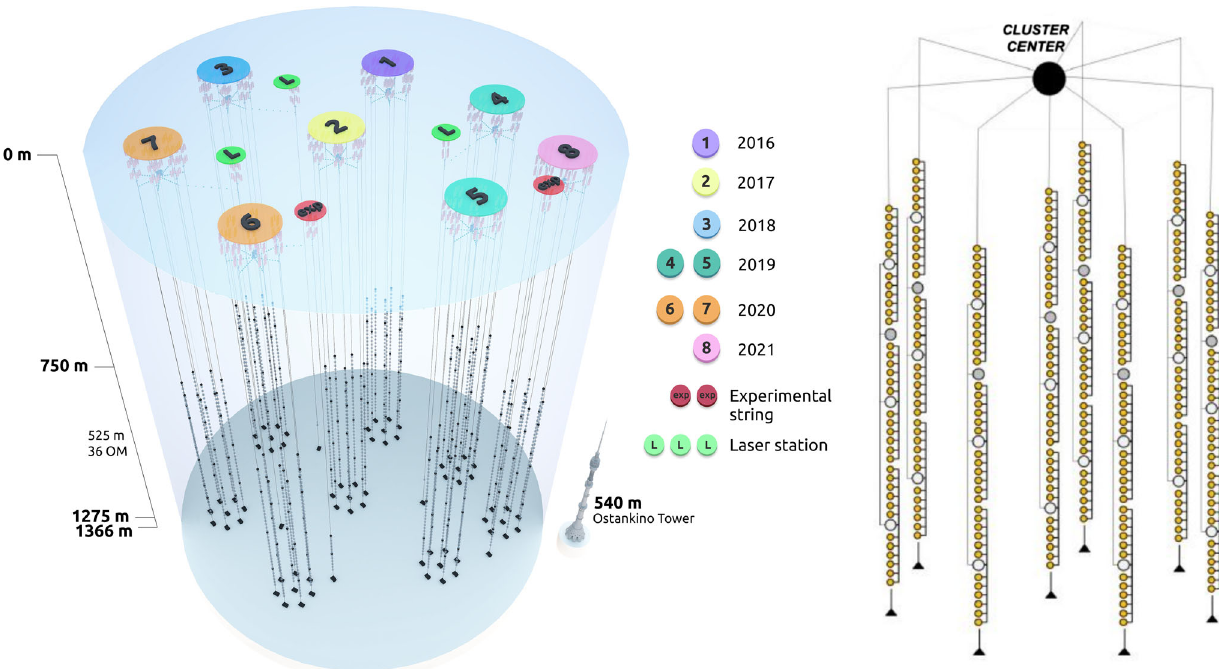
Fig. 1 Left: schematic view of the Baikal-GVD detector. The yearly progression of the detector deployment is shown in the legend. Right: the Baikal-GVD cluster layout (vertical scale compressed)